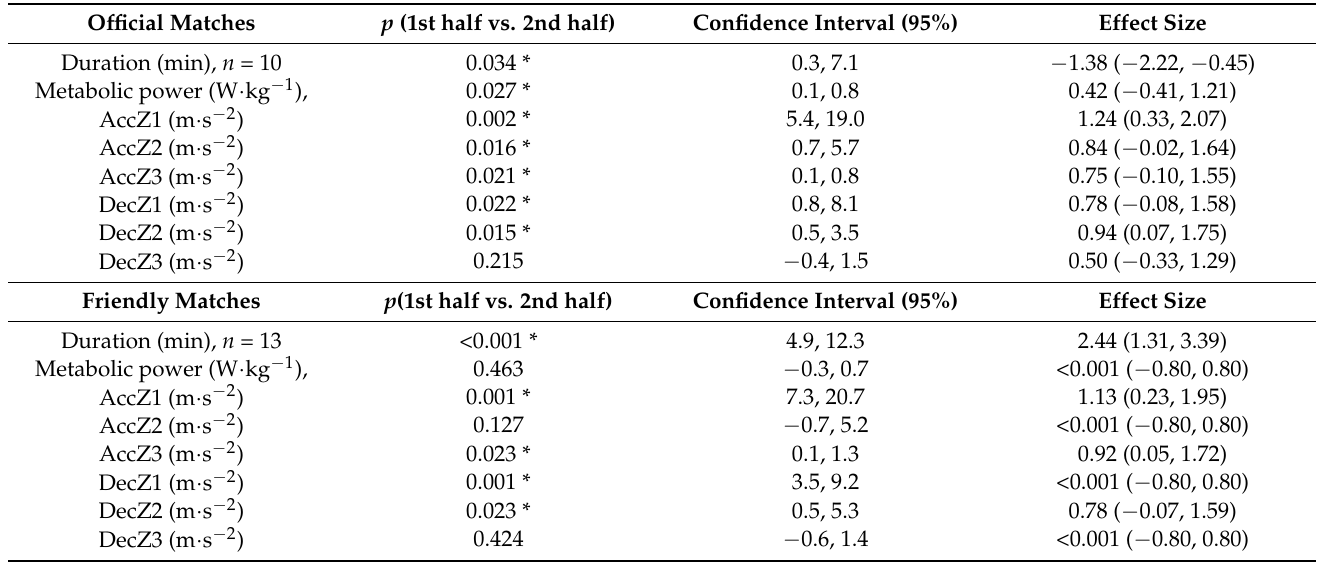
Table 3. Comparison of first and second halves during official and friendly